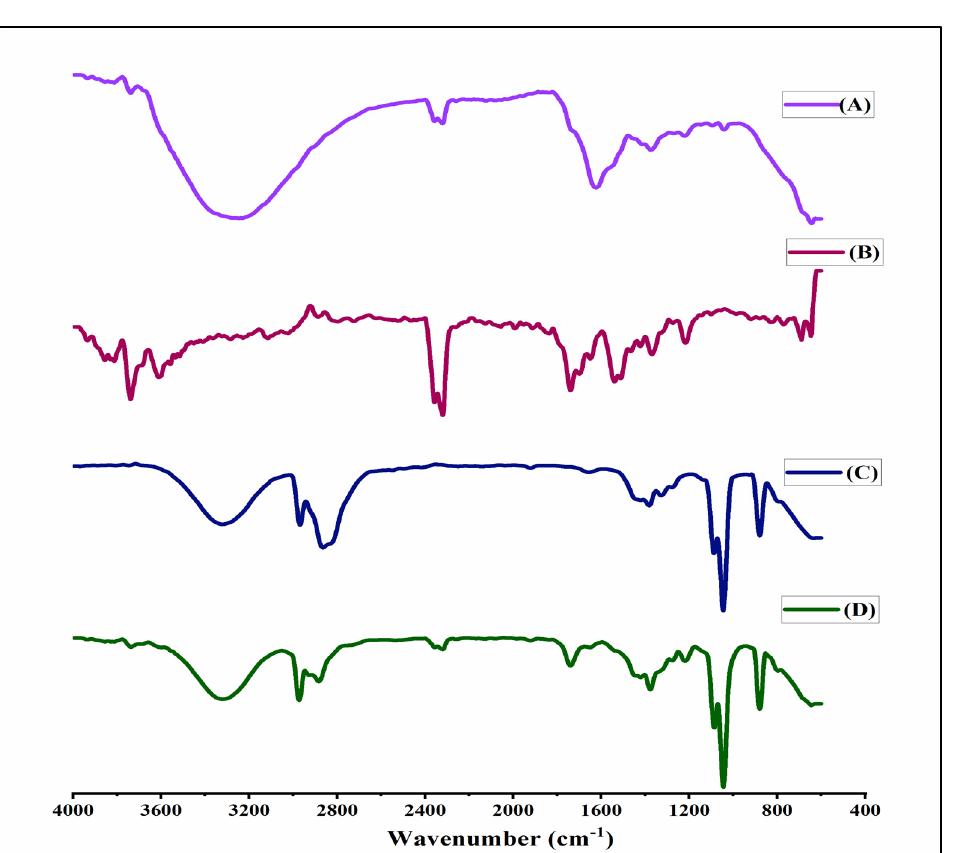
Figure 4. FTIR spectra of ( A ) SPIONs (10 mg), ( B ) TMX (10 mg), ( C ) BSA (10 mg), and ( D ) BSA- SPIONs-TMX (10 mg).